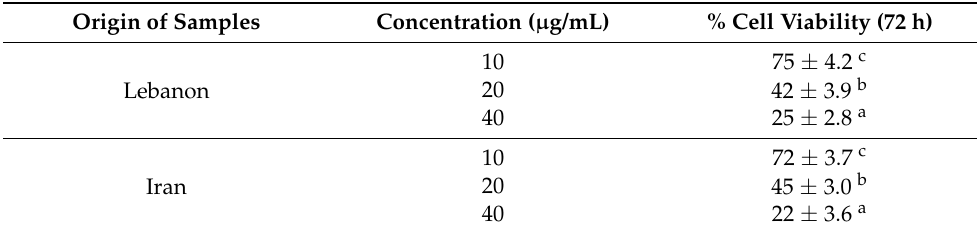
Table 2. Effect of saffron samples on A549 cell viability.